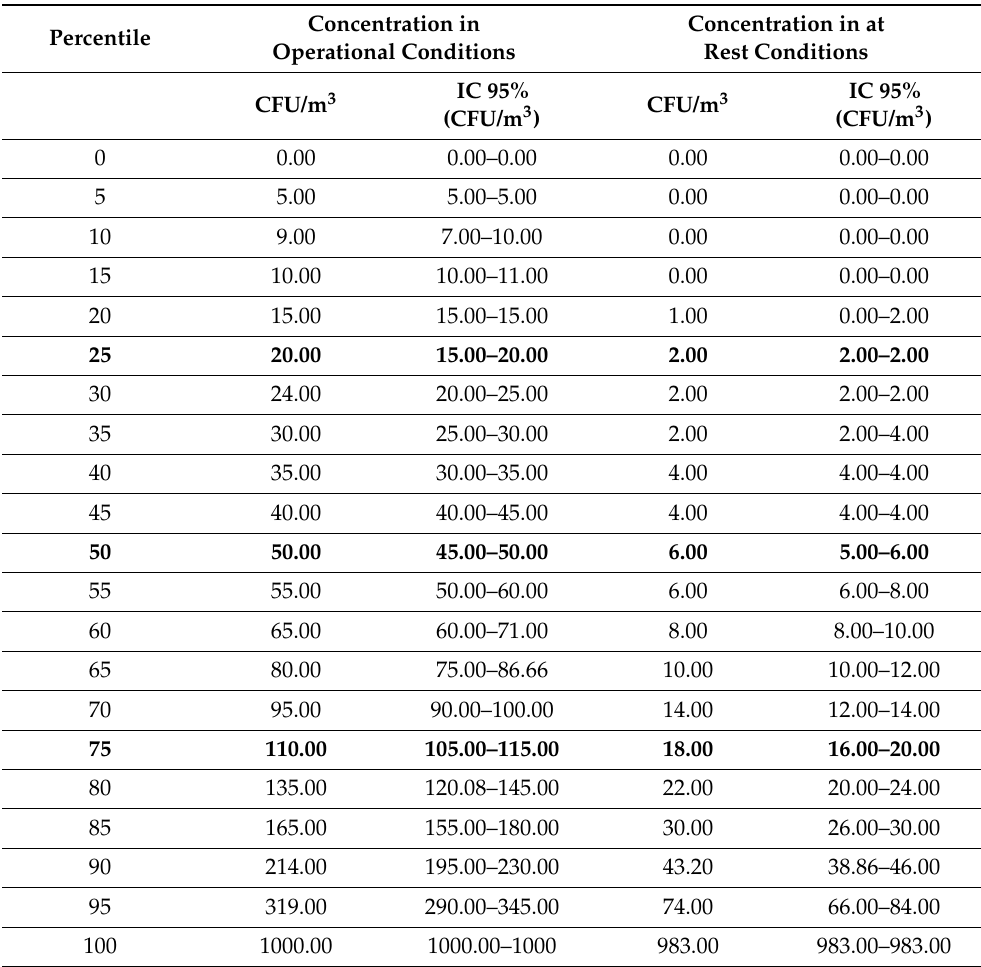
Table 2. Percentile distribution of data related to the microbial concentration in operating theatres in operational and at rest conditions during the years of observation. Concentration in Concentration in at Percentile Operational Conditions Rest Conditions IC 95% IC 95% CFU/m 3 CFU/m 3 (CFU/m 3 ) (CFU/m 3 ) 0